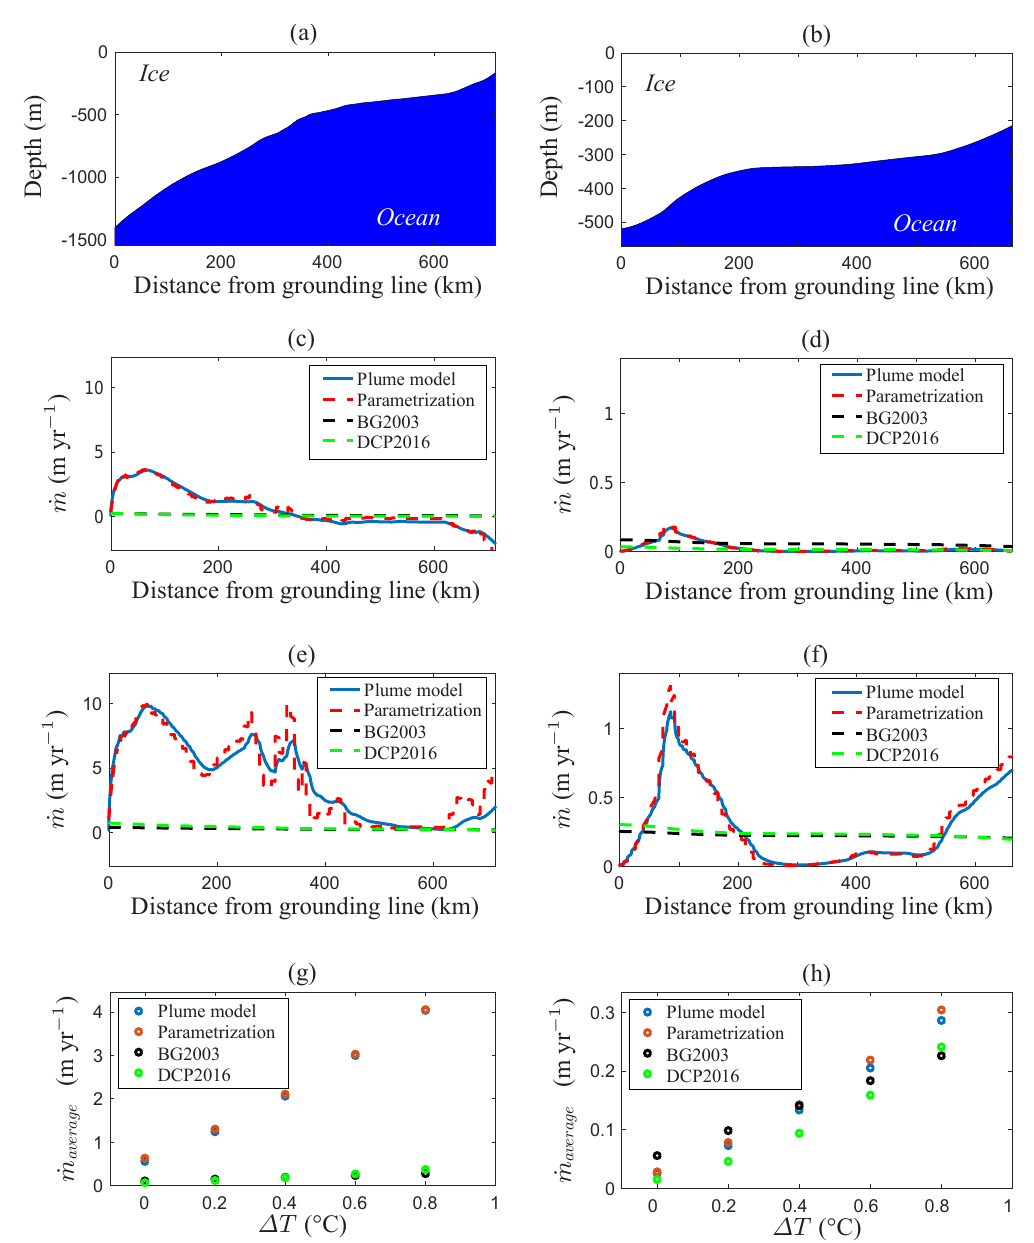
Figure 5. Comparison of the plume model (Sect. 2.1) with the 1-D basal melt parametrization (Sect. 2.2), as well as the parametrizations of Beckmann and Goosse (2003) (BG2003) and DeConto and Pollard (2016) (DCP2016), for flow lines along Filchner–Ronne Ice Shelf (a, c, e, g) and Ross Ice Shelf (b, d, f, h) , both with uniform ocean temperature T a =− 1.9 ◦ C + (cid:49)T and constant salinity S a = 34.65psu. (a, b) Geometry of the ice-shelf base. (c, d) Melt pattern for (cid:49)T = 0 ◦ C. (e, f) Melt pattern for (cid:49)T = 0.8 ◦ C. (g, h) Melt-rate average along the flow line as a function of (cid:49)T . Note that the black curve is nearly identical to the green curve and might appear below it. Also note the difference in vertical scale between the left and right columns. The flow-line locations are indicated in Fig.